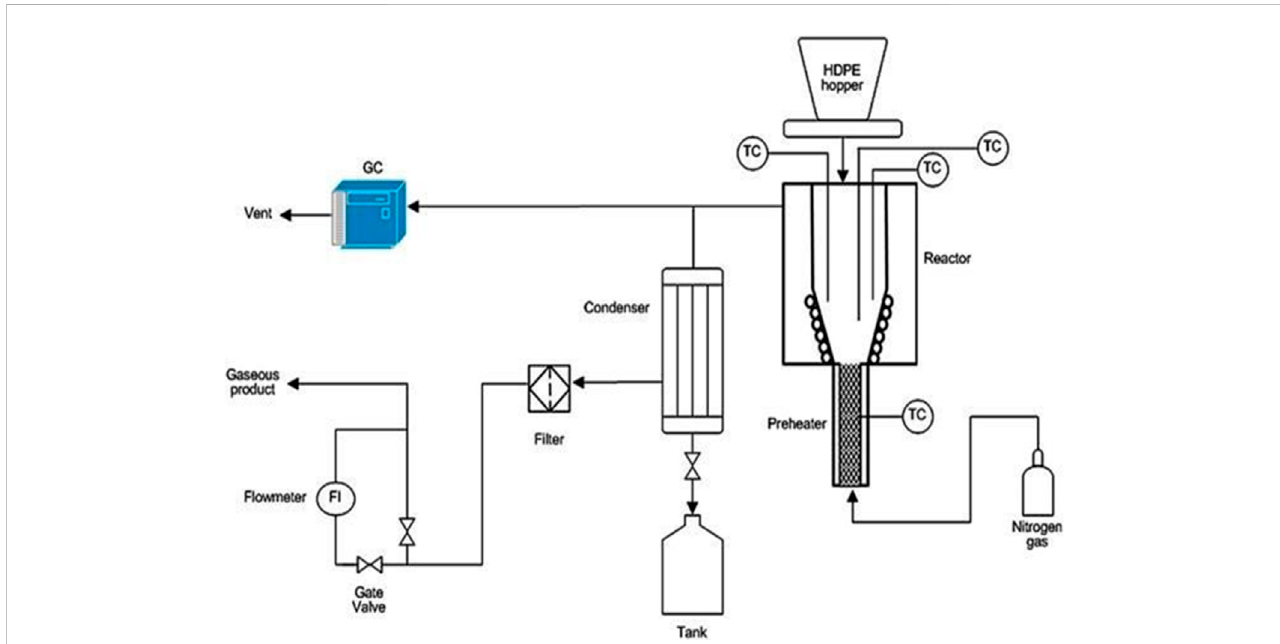
FIGURE 13 CSBR illustration in pyrolysis of HDPE in the presence of zeolite catalyst (Elordi et al.,